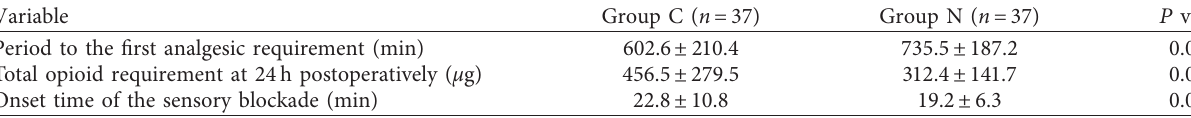
Table 2: Period to the first analgesic requirement, total opioid requirement at 24h postoperatively, and onset time of sensory blockade.